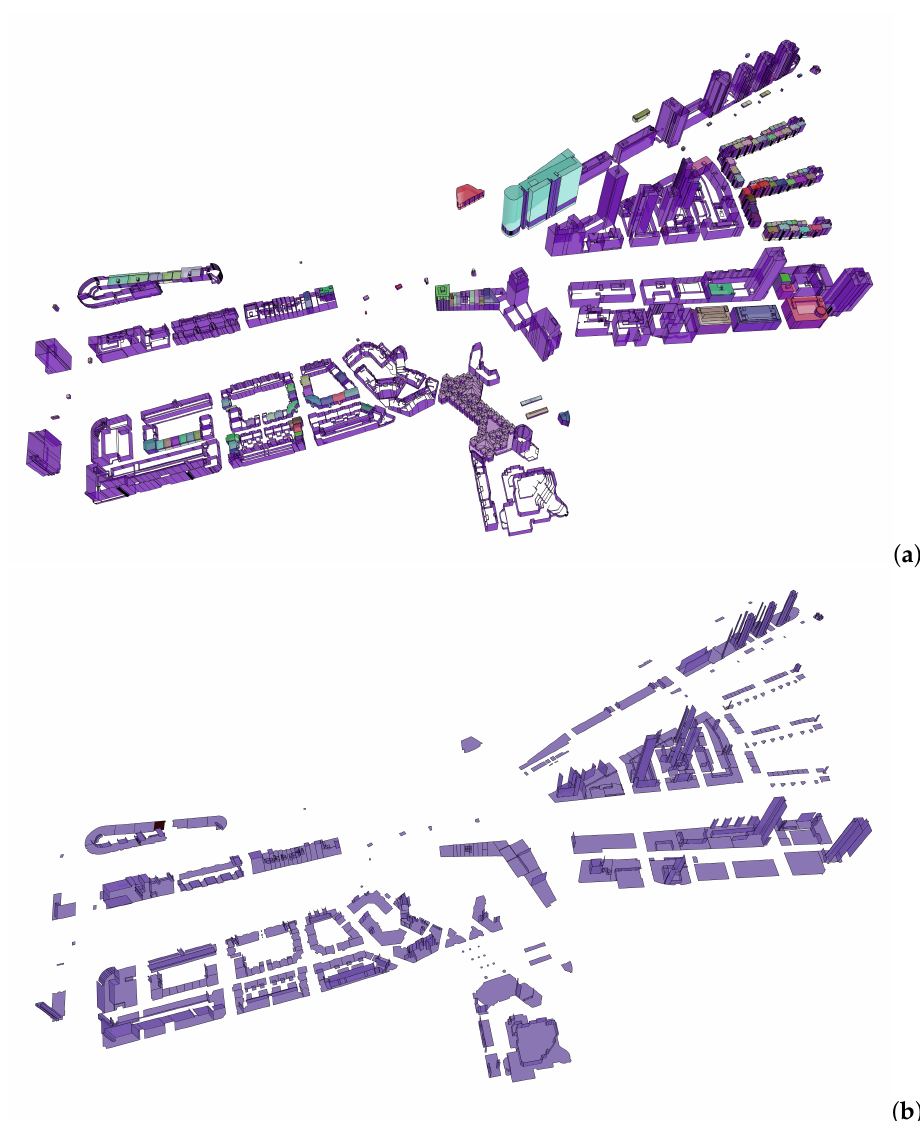
Figure 11. Result of FME conversion visualized in RDF IfcViewer. ( a ) IfcWalls in purple and IfcSpaces with various colours; ( b )